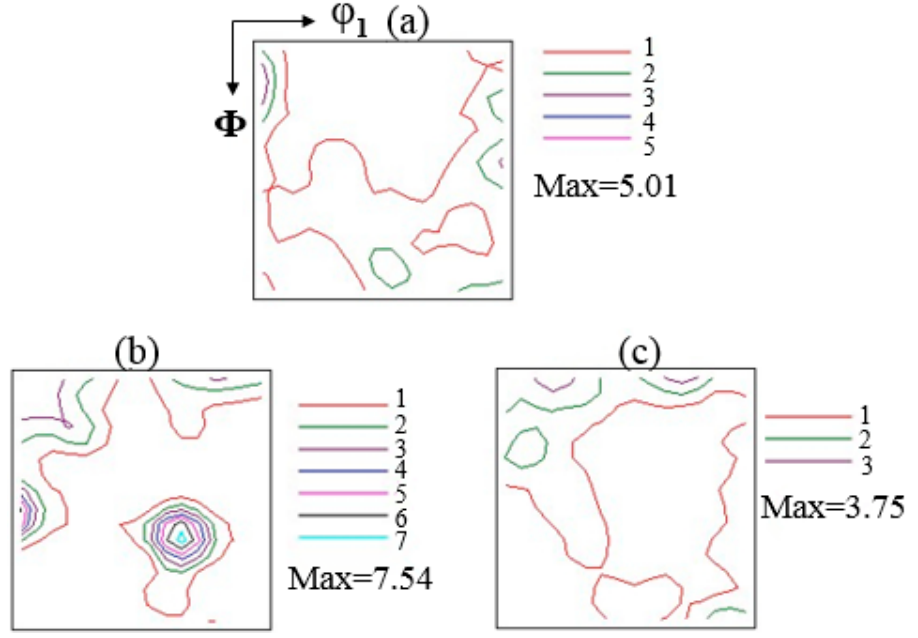
Figure 7. Texture ( ϕ 2 = 45° ODF section) of the specimens at different normalizing temperature, ( a ) 920 °C, ( b ) 950 °C, ( c ) 980 °C.